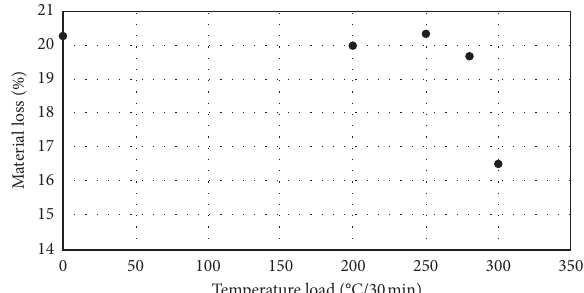
Figure 6: BMC-Charpy impact strength in relation to temperature